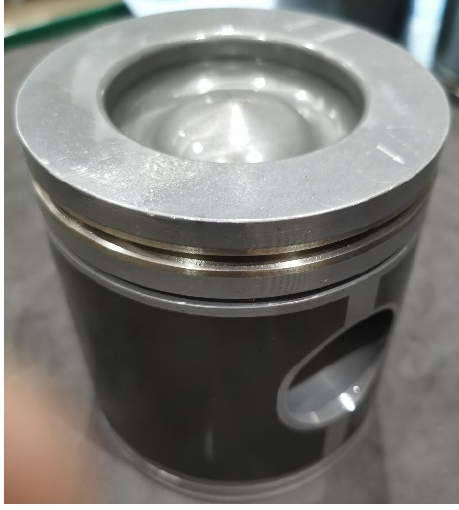
Figure 12. Bench test.